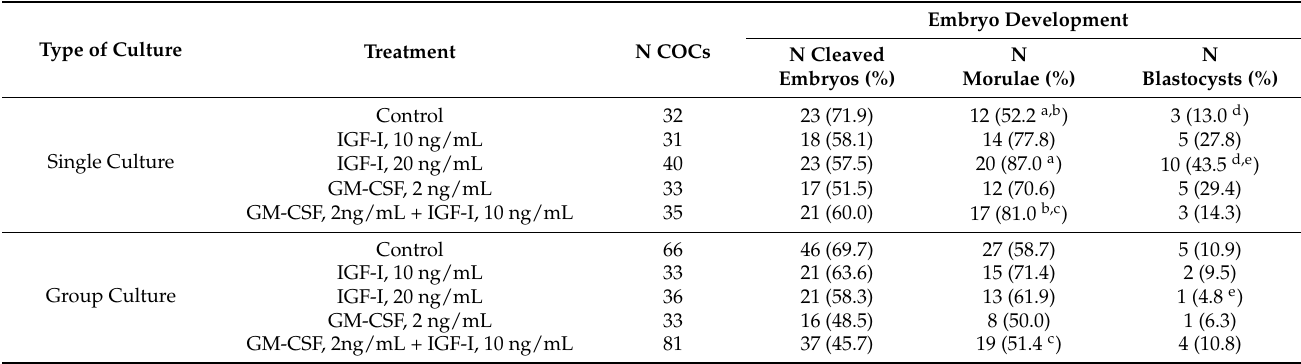
Table 1. Experiment A (Novosibirsk): Embryo development with different medium supplementation in single or group cultures.